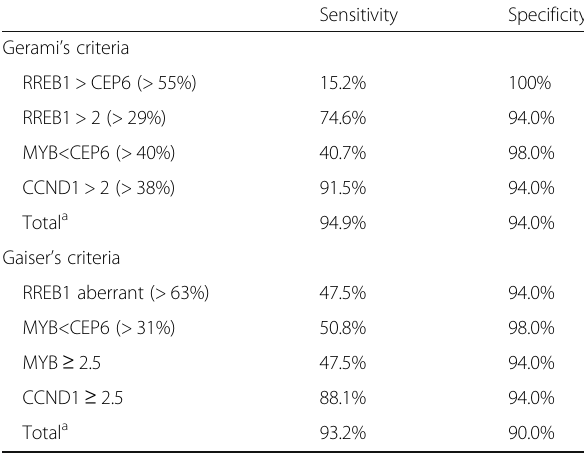
Table 3 Sensitivity and specificity of each criterion of Gerami and Gaiser in differentiating dysplastic nevi and early-stage acral and cutaneous melanomas Sensitivity Specificity Gerami ’ s